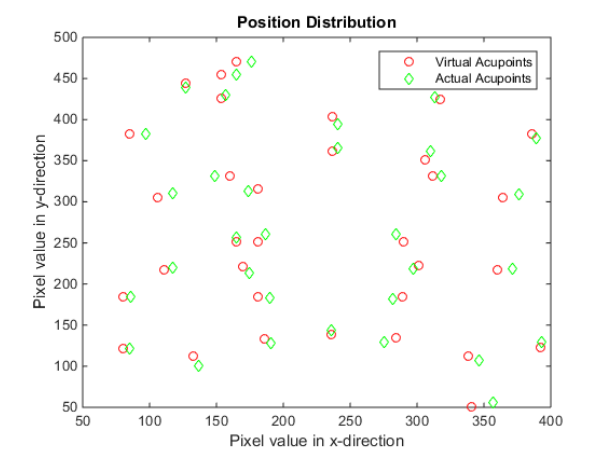
Table 2: The average accuracy bias verified by E-ACUPEN